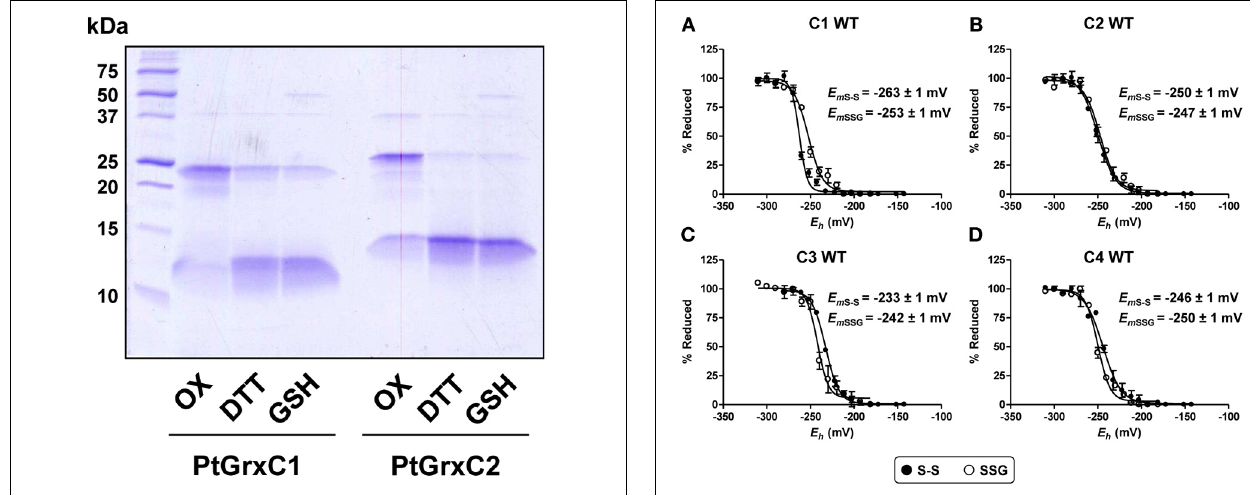
FIGURE 4 | GSH-dependent reduction of the intermolecular disulfide in poplar GrxC1 and GrxC2. The ability of GSH to reduce poplar disulfide-bridged dimer GrxC1 and disulfide-bridged dimer GrxC2 generated by a 2h H 2 O 2 treatment was evaluated in the presence of 1mM DTT and 1mM GSH coupled to NADPH and GR. The lanes Ox represent the initial oxidized proteins. Proteins were separated on SDS-PAGE gels under non-reducing conditions.